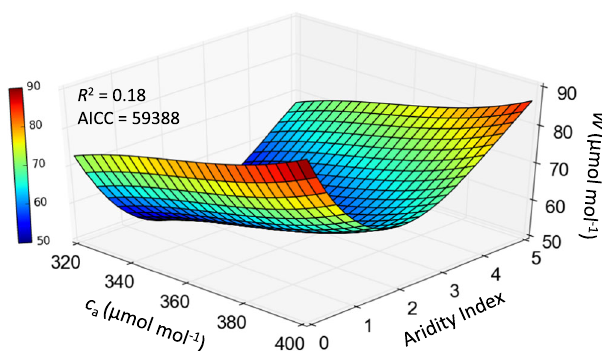
Fig. 3 Effect of atmospheric CO 2 ( c a , µ mol mol − 1 ) and aridity index (precipitation/potential evapotranspiration, mm mm − 1 ) on intrinsic water use ef fi ciency ( W , µ mol mol − 1 ) for the period 1965 – 2015. Polynomial regression of the combined effect of c a and aridity index on W . Aridity index calculated using TerraClimate data. AICC denotes Akaike ’ s Information